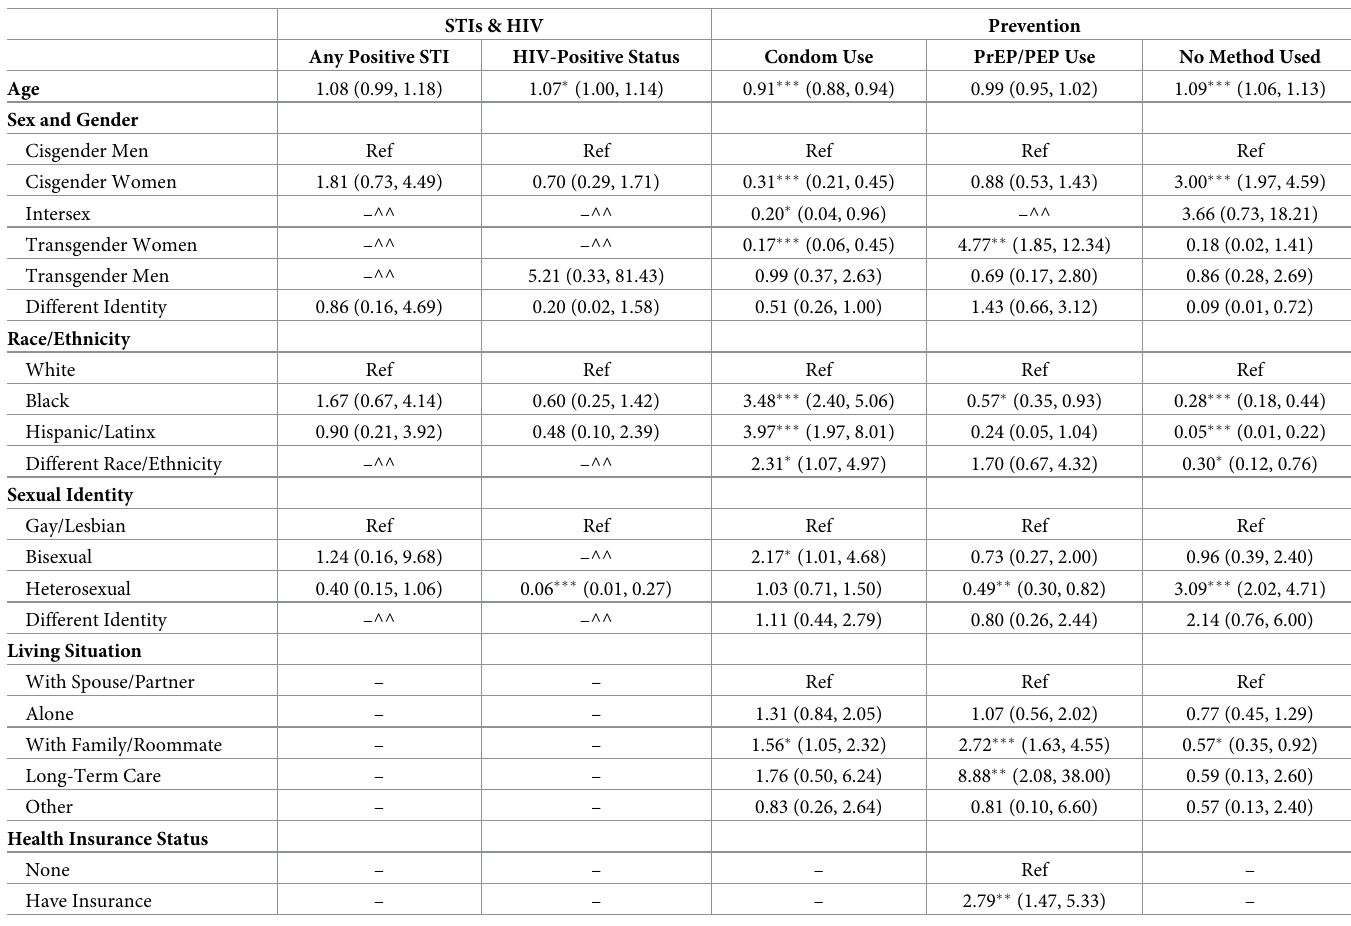
graphic variables and: 1) any positive STI test compared to none, 2) HIV-positive status rela- tive to HIV-negative status, 3) use of condoms to prevent HIV/STIs compared to no condom Table 2. Multivariable logistic regressions assessing self-reported HIV and STI test results and select prevention methods. STIs &